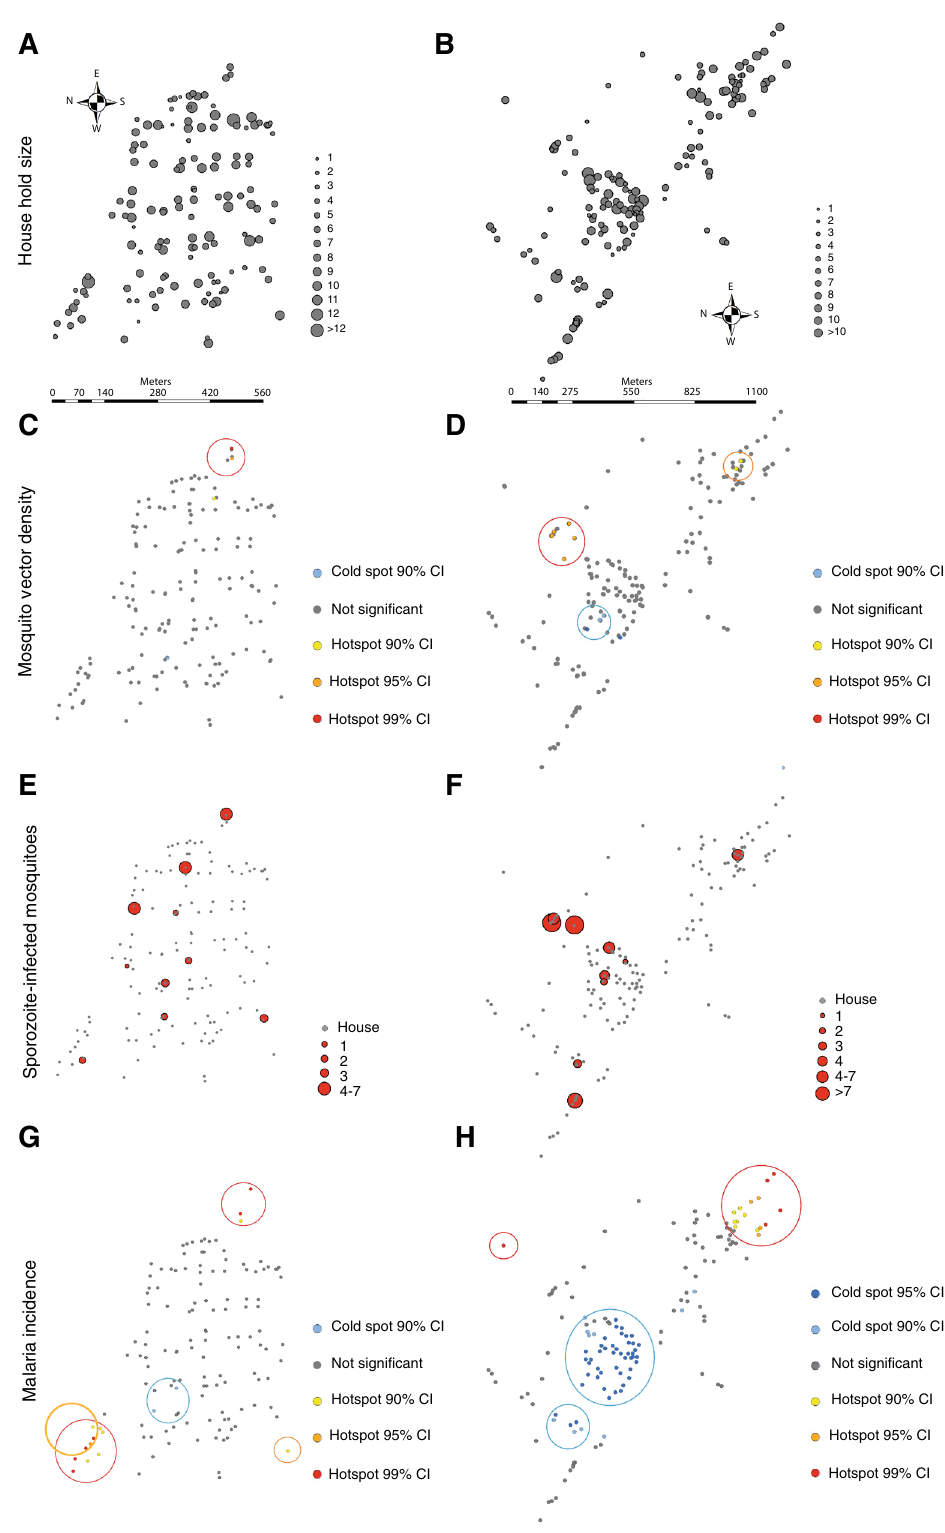
Figure 2. Living on the edge increases malaria incidence. The distribution of households and occupant density in Abulo ( A ) and Magge ( B ), in which the size of the circles indicate the number of inhabitants in each household. The scale bars indicate distance (m). Clustering of malaria mosquitoes generated from hotspot analyses in Abulo ( C ) and Magge ( D ) is shown. Cold- and hotspots are indicated with 90%, 95% and 99% confidence intervals (CI). The distribution and abundance of sporozoite- infected mosquitoes is mapped for Abulo ( E ) and Magge ( F ). The size of the circles indicates the number of sporozoite- infected mosquitoes. The clustering of malaria infected people and people with lower risk of getting the infection is revealed by the hotspot analyses for Abulo ( G ) and Magge ( H ). The coloured rings indicate the different significance levels of hot- and coldspots, with 90%, 95% and 99%